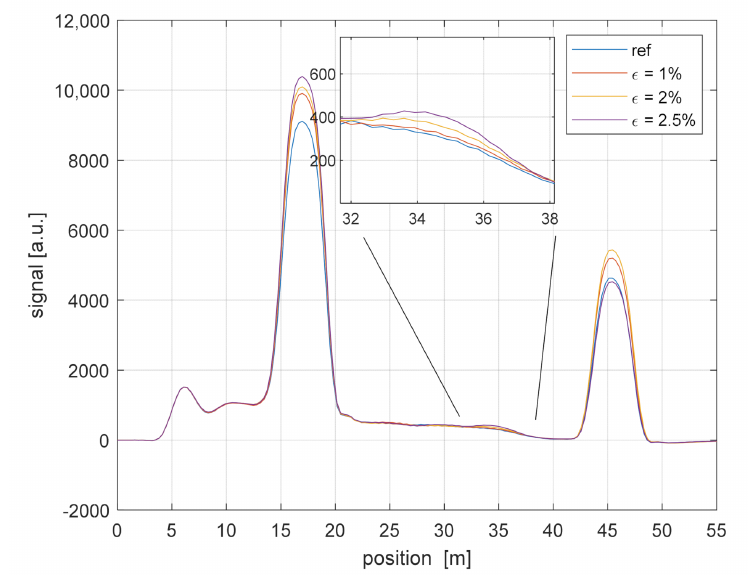
Figure 3. The φ -OTDR traces acquired over GI-POF for various strain levels.